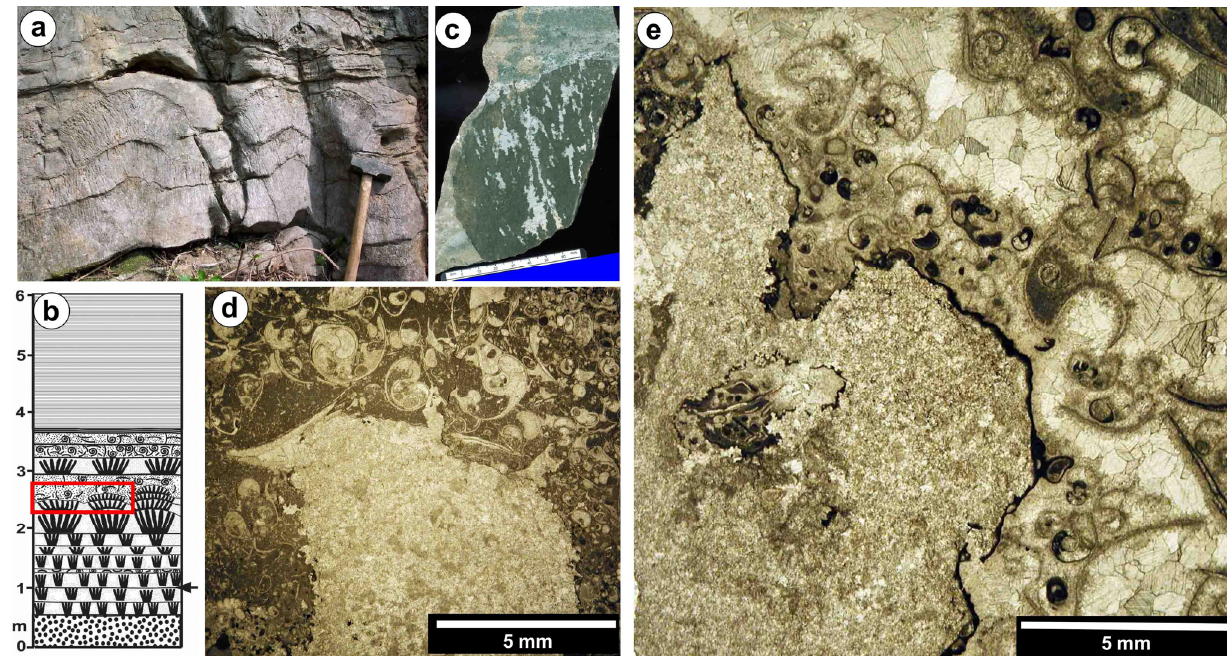
Figure 5 . Erosion in the upper part of a post-extinction microbialite at Dongwan in Sichuan Province [9,15]. ( a ) Field view of microbialite domes; ( b ) Log of the microbialite, showing the location of the area of ( a ) in the red box. The arrow lower right shows the level of the lowest occurrence of Hindeodus parvus , the marker conodont for the Permian-Triassic boundary; ( c ) Vertical section of a polished block showing eroded upper surface of the dome, enlarged in ( d ); ( e ) Another view of the eroded surface showing apparent dissolution and mineralization of the surface with opaque minerals. The eroded mineralized surface is covered by gastropod grainstone prior to final growth of microbialite shown in ( b